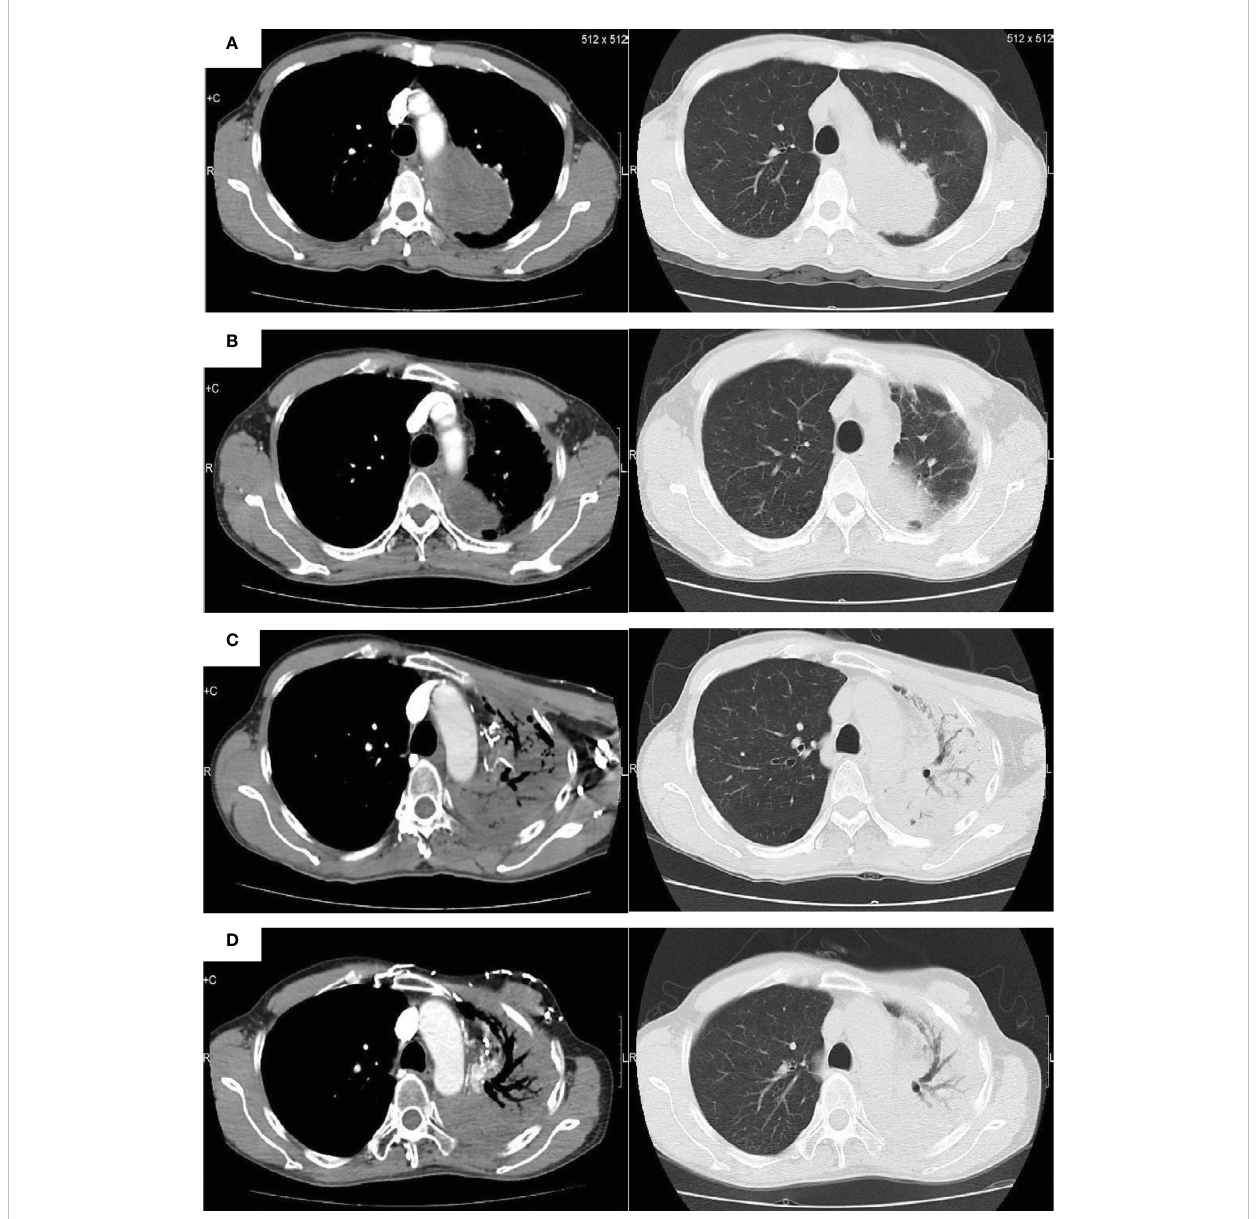
FIGURE 3 Radiologic images of the pulmonary blastoma patient. (A) Baseline image. (B) Image obtained following completion of fi rst-line chemotherapy and radiotherapy. (C) Image obtained prior to anti-PD-1 immunotherapy. (D) Image obtained after anti-PD-1